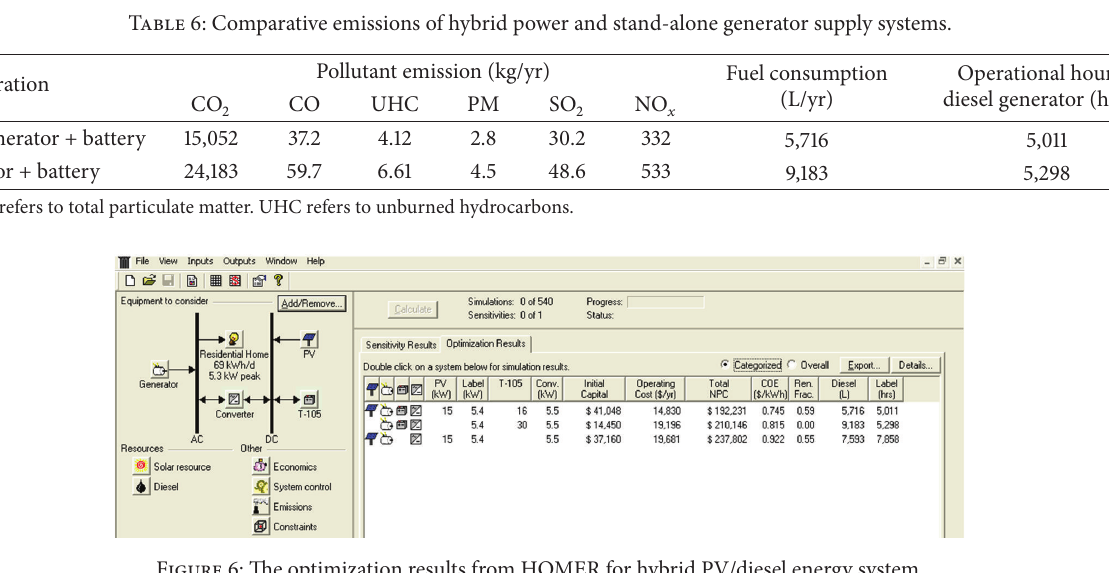
Figure 6: The optimization results from HOMER for hybrid PV/diesel energy system.